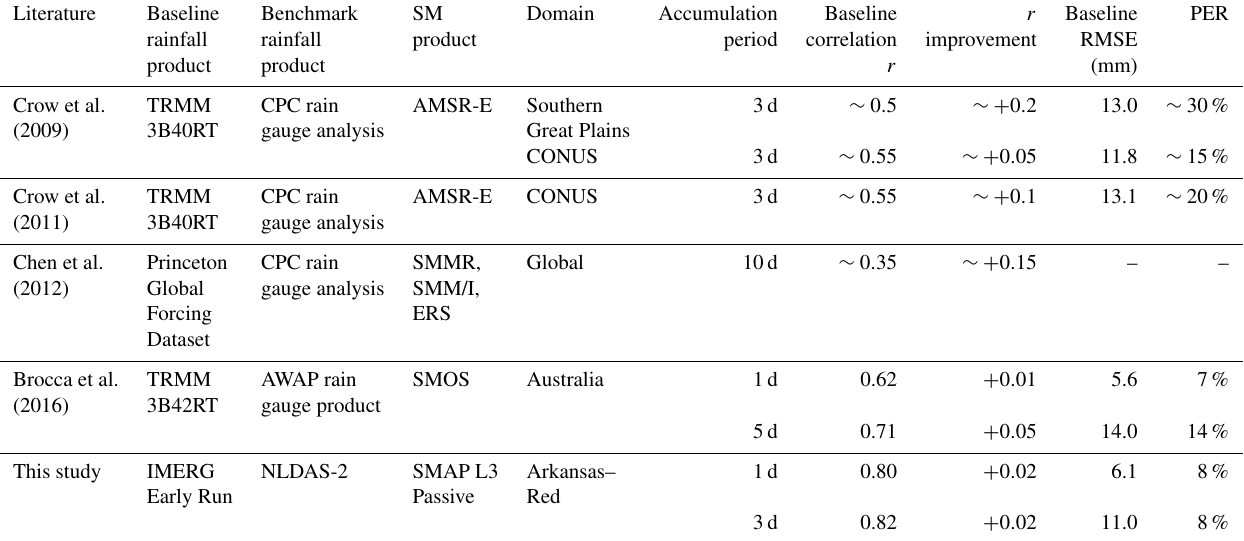
Table 3. Review of SMART rainfall correction results in literature along with the results in this study. CPC: Climate Prediction Cen- ter; AMSR-E: Advanced Microwave Scanning Radiometer for the Earth Observing System; SMMR: Scanning Multichannel Microwave Radiometer; SSM/I: Special Sensor Microwave Imager; ERS: European Remote Sensing satellites; AWAP: Australian Water Availability